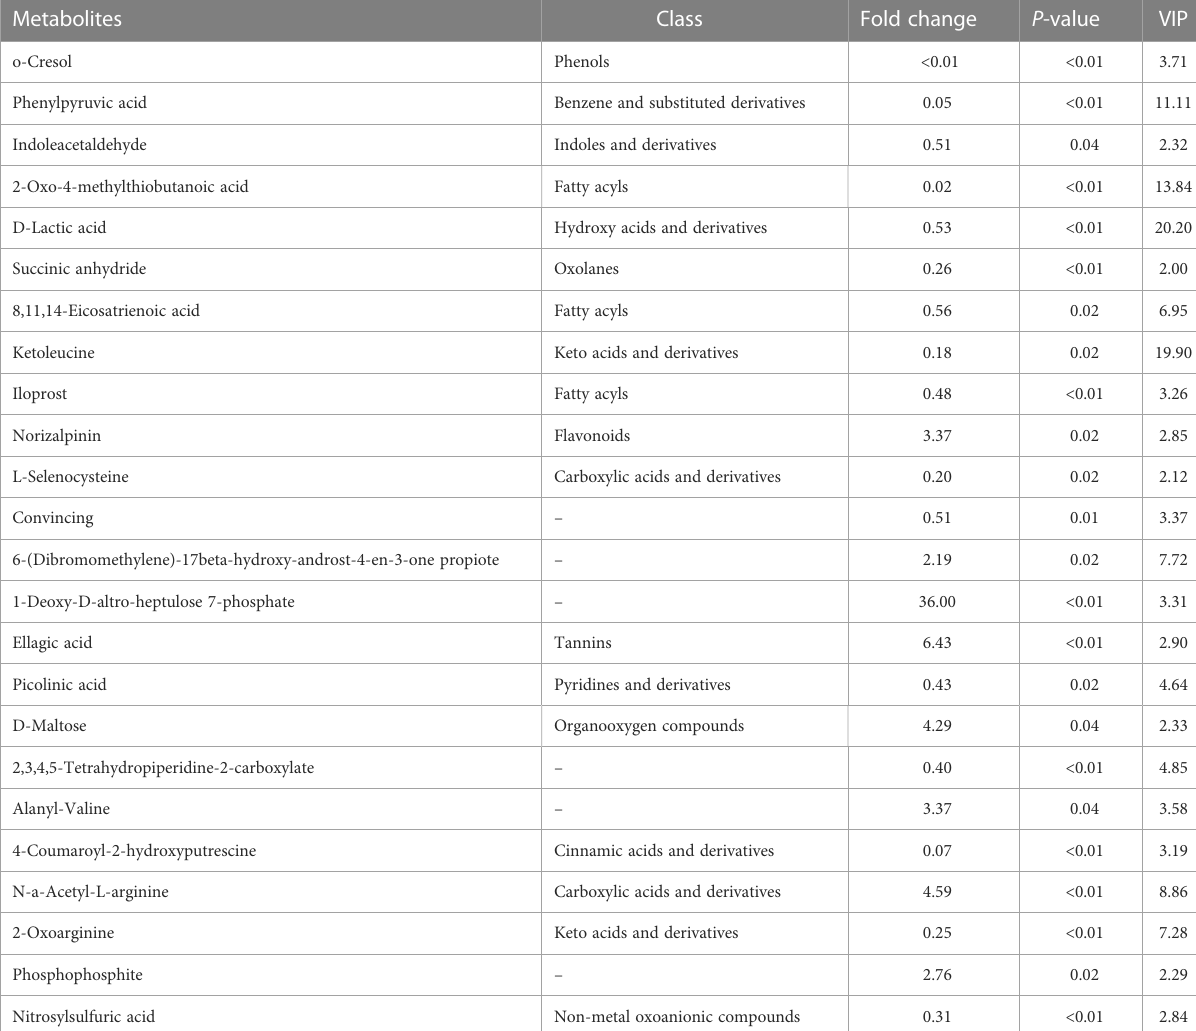
TABLE 1 Differences in the metabolite pro fi les between the control and Cyprinid herpesvirus 2 (CyHV-2)-infection groups